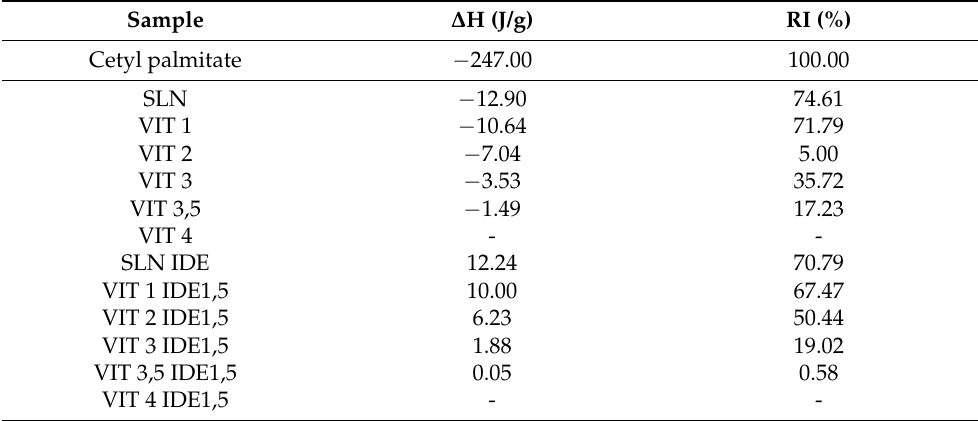
Table 3. Enthalpy changes ( Δ H) and recrystallization index (RI%) of unloaded SLN and NLC, IDE- loaded SLN, and 5% w / w IDE-loaded NLC.